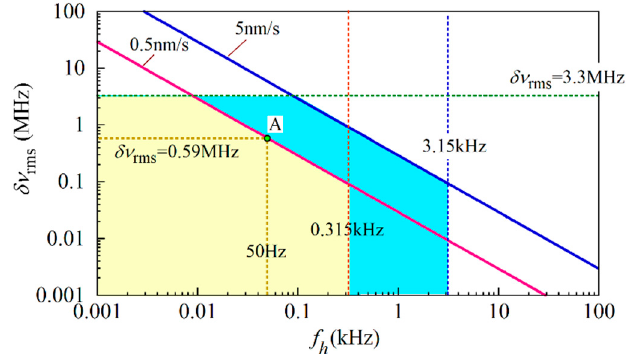
Figure 12. Domain highlighted in yellow where ( f h , δν rms ) satisfies the three conditions described by the relational expressions (21), (22) and (23) to achieve ( S / N ) tgt = 200 at τ e = 48.4 ns, γ = 62.5 GHz. The segment highlighted in blue is the domain extended by increasing the sweep rate to γ = 625 GHz/s. The red and blue solid lines show the boundary curves defined by δν rms = 0.0293/ f h and δν rms = 0.293/ f h in a log-log scale to satisfy the third expression (23) at 0.5 nm/s (= 62.5 GHz/s) and at 5 nm/s (= 625 GHz/s), respectively.